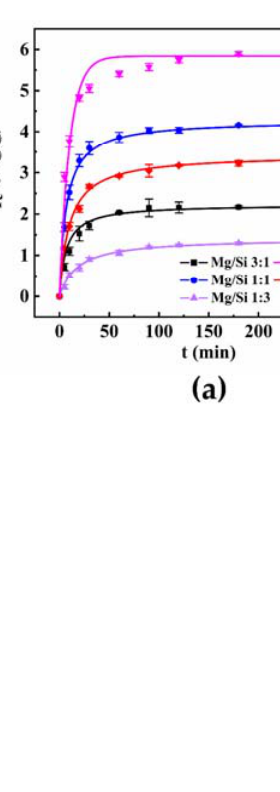
Table 2. Adsorption kinetic parameters of 4 −